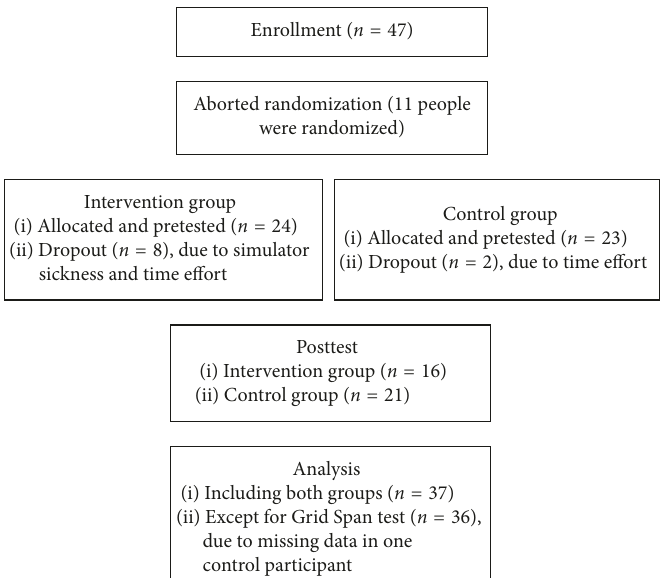
Figure 1: Study flowchart describing participants’ allocation in both groups. Enrollment started in November 2015, and the study was finished in September 2016.